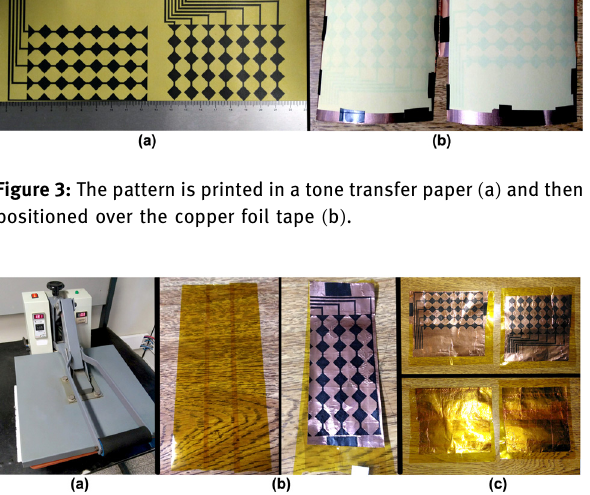
Figure 4: The heat press printer machine ( a ) is used for transferring the pattern from the paper to the copper foil. The copper foil is glued in the polyamide tape ( b ) and the parts of each layer are joined ( c ) .